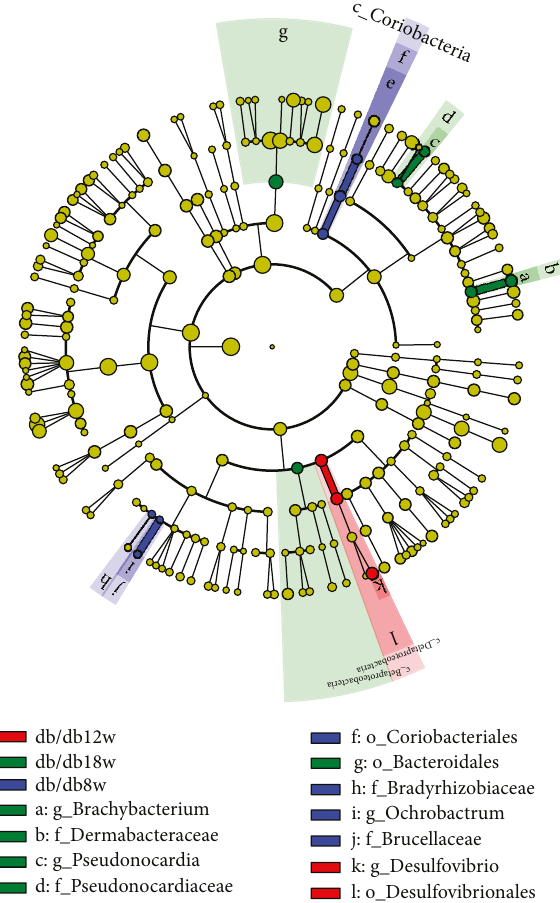
Figure 5: Cladogram representing a signi fi cantly high abundance of taxa in the gut microbiota of db/db mice at 8, 12, and 18 weeks of